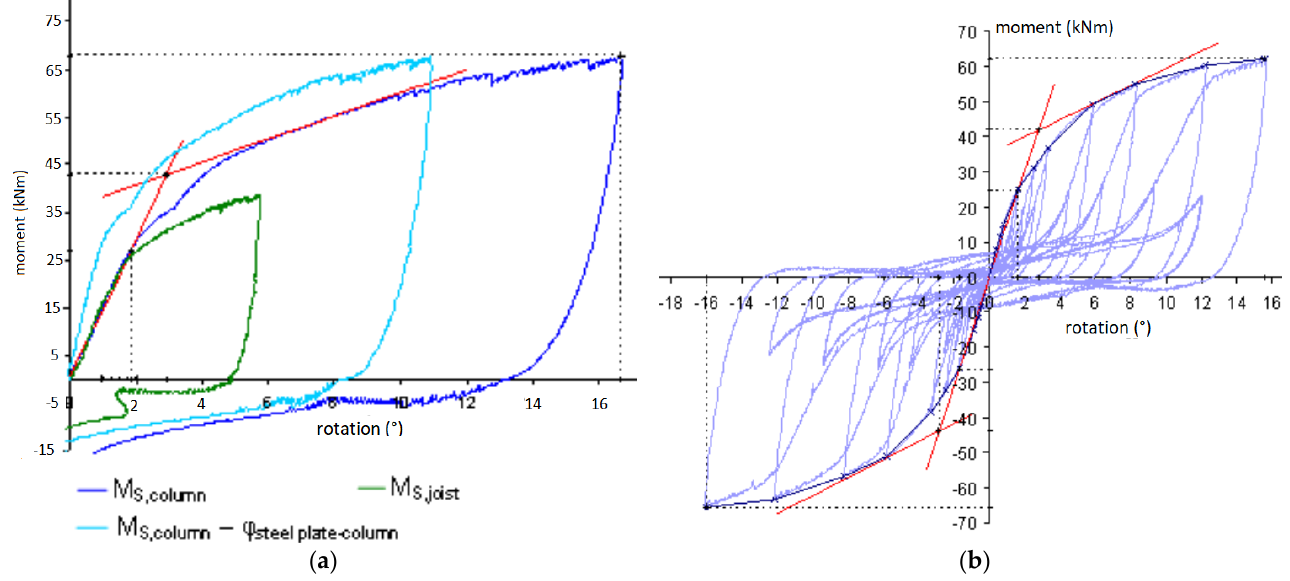
Figure 6. Moment–rotation curves of the reinforced connection. ( a ) Monotonic load, ( b ) cyclic load, (adapted from